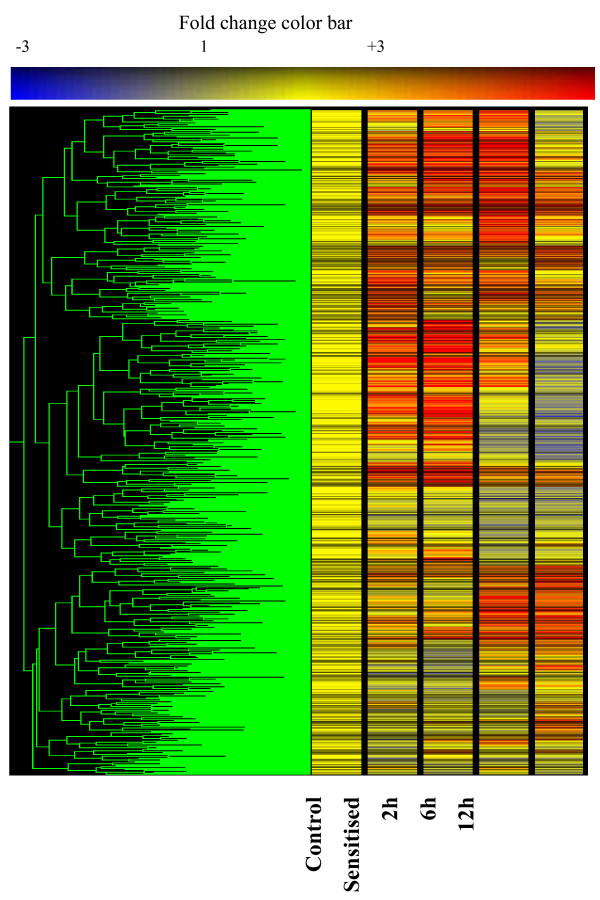
Changes in gene expression in human mast cells following IgE sensitization and FcεRI aggregation. Changes in expression over control of human cord blood derived mast cells that were activated by IgE sensitization and FcεRI crosslinking for different time points (2 hr, 6 hr and 12 hr). Labelled cRNA from cell of each time point were hybridized to Human Genome Focus array and signals were scanned after fluidics. The data was analyzed as described in material and methods and analysis revealed differential expression of 760 genes between resting and stimulated mast cells with statistical significance (P ≤ 0.05). Agglomerative average-linkage hierarchical clustering of the five different experimental conditions was obtained for selected groups of genes using GeneSpring 7.0. Each colored box represents the normalized expression level of a given gene in a particular experimental condition and is colored according to the color bar. The data represent average of four independent experiments.